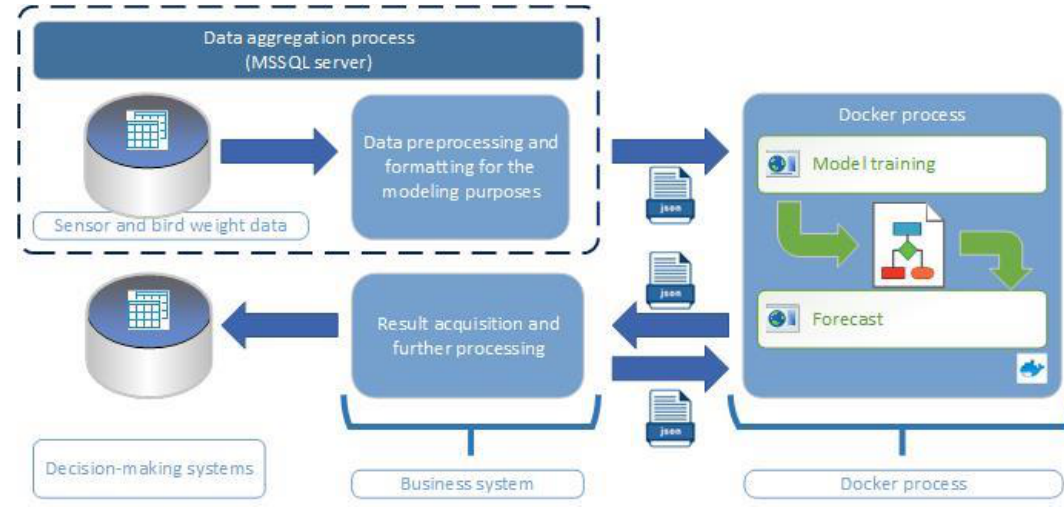
Figure 7 . The architecture of the data processing software system